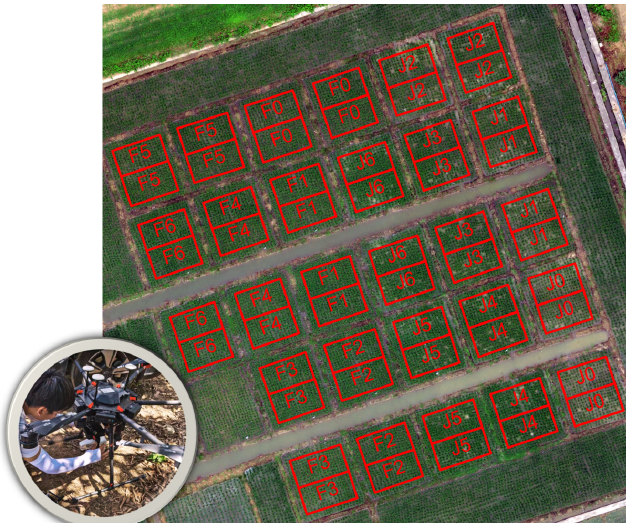
Figure 1. Demonstration of sample areas, nitrogen treatment leaves and hyperspectral camera setup. J0–J6 received 0, 30, 60, 90, 120, 150 and 180 (kg ha − 1 ) nitrogen, respectively, at 7 DAT; F0–F6 each